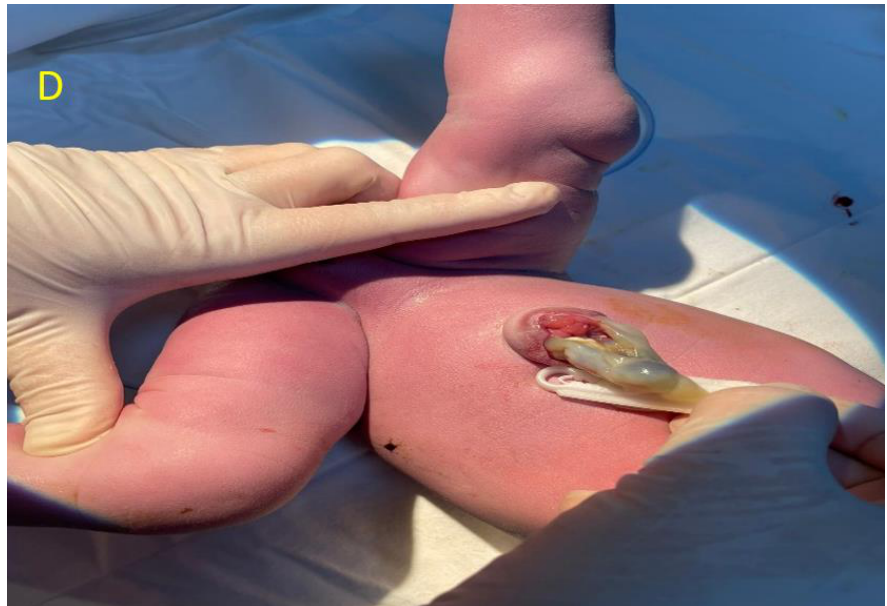
Figure 1. We present a case of a 25-year-old G3P1, fit and healthy, who presented to our unit in her first trimester for the combined screening test assessment [1,2]. The early ultrasound assessment of the fetal anatomy demonstrated a cystic structure at the level of fetal cord insertion that was connected to fetal bladder, measuring 21.1 × 23.1 mm ( A ). The suspicion of allantoic cyst [3] was raised due to the patent urachus demonstrated on the ultrasound assessment [4]. An additional umbilical cyst was seen next to the allantoic cyst. Differential diagnosis with umbilical cord cyst, omphalocele and bladder exstrophy has been considered [5]. No other obvious major abnormalities have been seen and the nuchal translucency was within normal limits with a low chance for common trisomies (T21/T13/T18) from the combined screening test. A follow up scan at 16 weeks showed similar findings with the previous scan, the cystic structure keeping smaller measurements (14.7 × 15.1 mm) ( B ). The anomaly scan at 19 weeks demonstrated no other structural anomalies beside the cystic structure that was measuring smaller than before (11.1 × 14.5 mm) ( C ). In view of this findings, the mother chose to have invasive testing (amniocentesis), and the result of microarray showed 1.82 Mb microdeletion in the 1q21.1q21.2 region. The consequences of 1q21.1 microdeletion may include mild developmental delay, dysmorphic craniofacial features, microcephaly, eye abnormalities, cardiac defects, brain malformations as hydrocephalus and agenesis of the corpus callosum [6,7]. Genitourinary anomalies as vesicoureteral reflux, hydronephrosis, inguinal hernia, and cryptorchidism can be present [8]. Because the clinical spectrum is broad and persons with deletion do not have obvious clinical findings, the family decided to continue the pregnancy [9]. In order to establish the familial or “de novo” origin of this microdeletion, parental testing (microarray/qPCR) is advised [10]. The pregnancy evolved without complications and the third trimester scan showed small measurements of the cystic structure. A live neonate was delivered at 39 weeks by elective caesarean, weighing 3000 g ( D ). The neonate underwent surgical repair of the abdominal wall in the first weeks of life and no other complications have been reported during postnatal care. We have followed up the child within the first year of life and no dysmorphic craniofacial features, microcephaly, or renal disorders have been reported. In terms of brain development, the baby achieved the expected milestones for the first year of life including rolling over, sitting up, standing, and initially